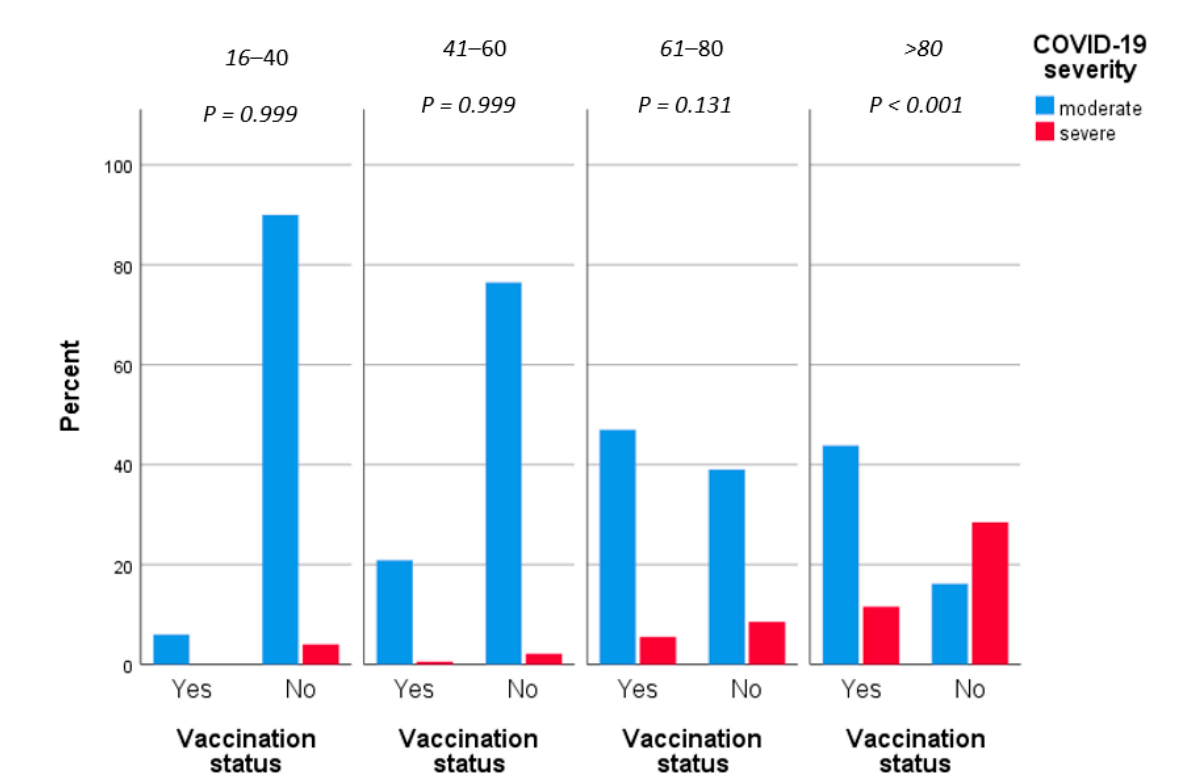
Figure 2. Severity grouped by vaccination status.